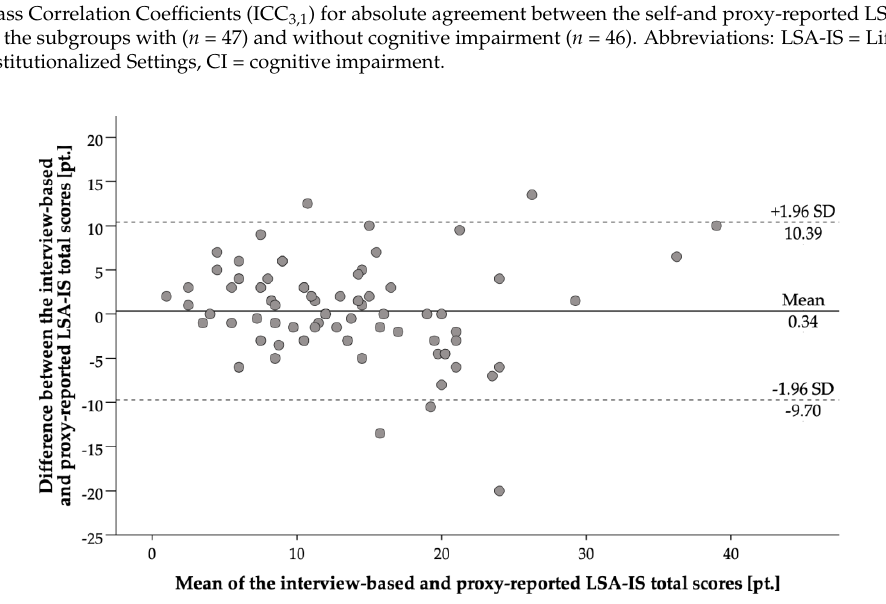
Figure 1. Bland-Altman plot for agreement between proxy-reported and self-report LSA-IS. Note: Presented is a Bland-Altman plot for agreement between proxy-reported and self-report LSA-IS. The solid line indicates the mean between-method difference (bias) and dashed lines the upper and lower 95% LOA (± 1.96 SD of the bias). Table 2. Concurrent validity of the LSA-IS-proxy with the self-reported LSA-IS.